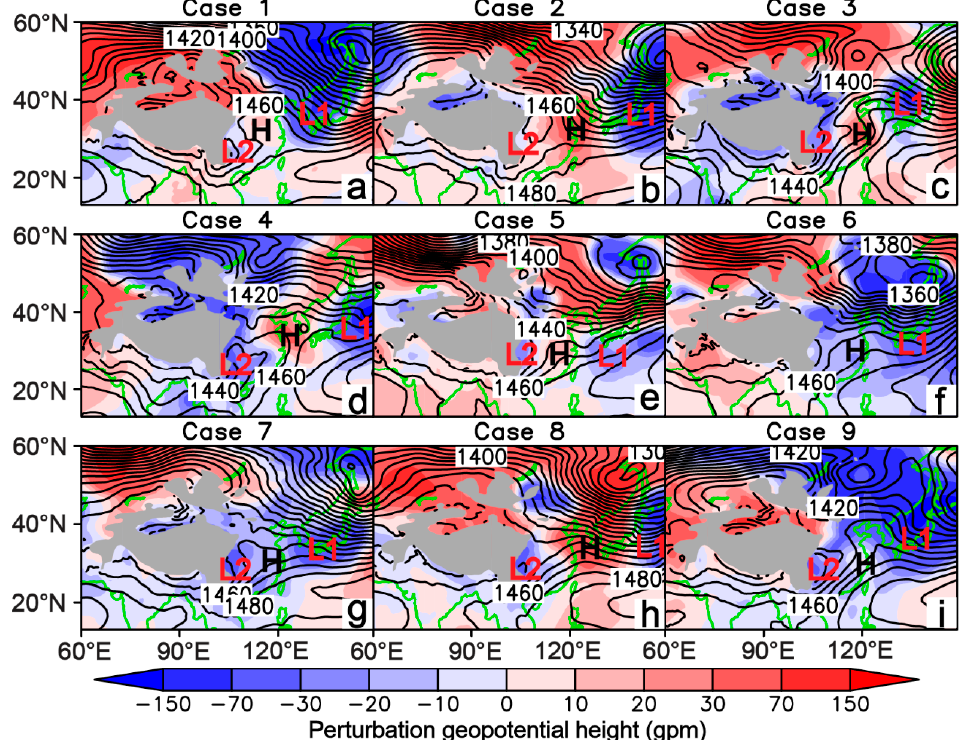
Figure 7. Distributions of synoptic-scale transient anomaly (SSTA; color-shaded) and 10-yr (2008–2017) averages (contours) of geopotential height (GH; units: gpm) at 850 hPa near the time when MCSs turned to move southeastward ( a – i : cases 1–9; a : 1400 BT 11 April 2012; b : 0800 BT 6 April 2014; c : 2000 BT 8 May 2014; d : 1400 BT 22 May 2014; e : 1400 BT 30 April 2015; f : 0800 BT 5 May 2015; g : 1400 BT 4 April 2016; h : 0800 BT 15 April 2016; i : 0800 BT 19 April 2017). “H”, “L1” and “L2” indicate the high synoptic-scale transient anomaly of low-level geopotential height (SSTA-GH) near eastern China and the low SSTA-GHs over northwestern Pacific Ocean and southwestern China, respectively. The gray-shaded area are Tibetan